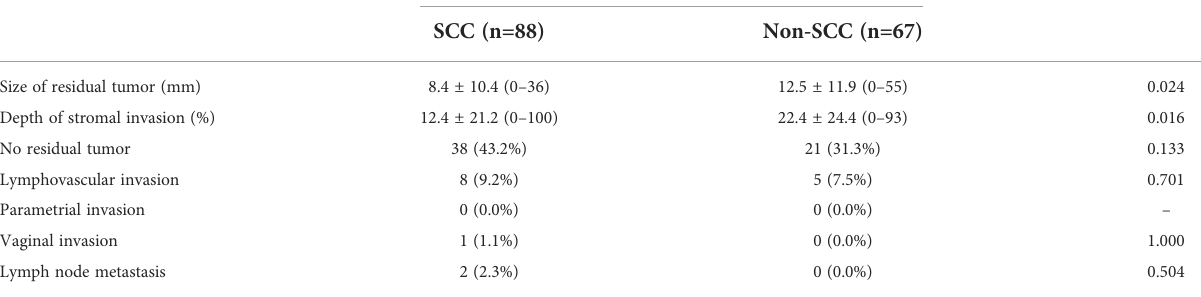
FIGO stage IB1 cervical